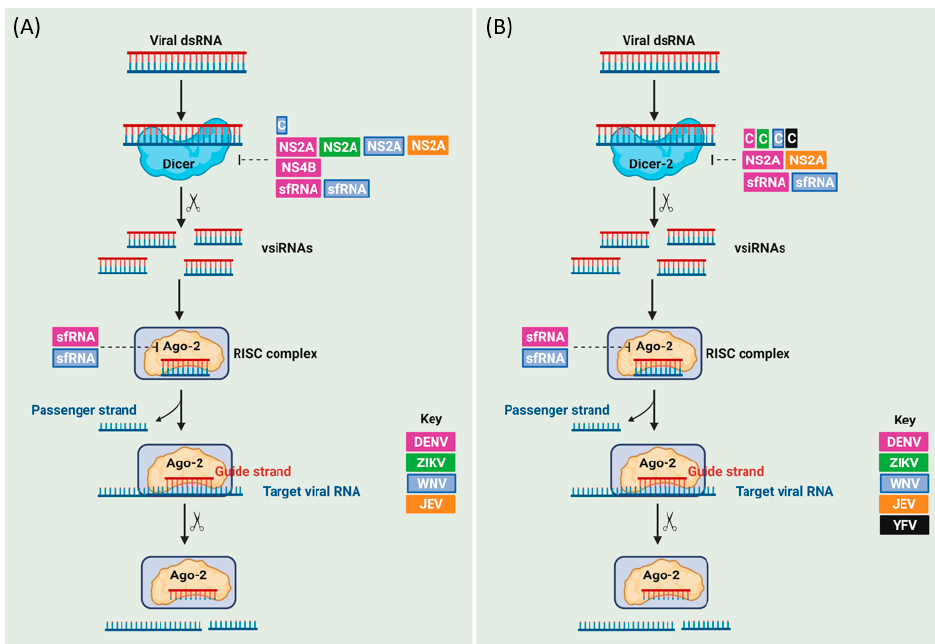
Figure 4. The exo-siRNA pathway in response to mosquito-borne flavivirus infection and its antagonism in humans ( A ) and mosquitoes ( B ). dsRNAs generated during viral replication in mosquitoes are recognized by the PRR Dicer-2 which cleaves the dsRNAs into 21-nucleotide virus-derived siRNAs (vsiRNAs) [122]. The vsiRNA duplex is then incorporated into Argonaute proteins (Ago2) leading to the formation of the RNA-induced silencing complex (RISC) [123]. The passenger strand of the vsiRNA duplex is eliminated from the activated RISC, while the guide